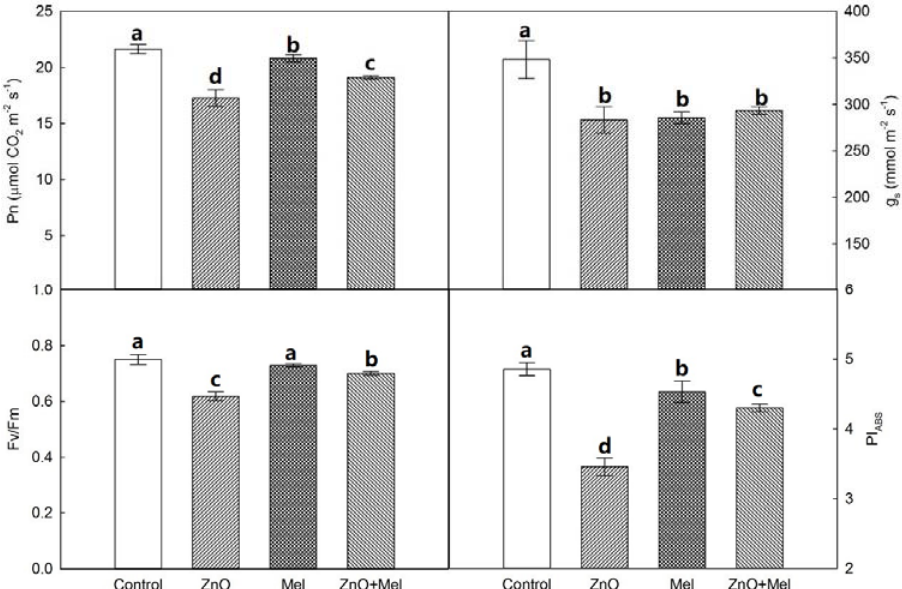
Figure 3. Net photosynthetic rate (Pn), stomatal conductance ( g s ), maximum quantum efficiency of photosystem II (Fv/Fm), and performance index (PI ABS ) in the last fully expanded leaf in wheat as affected by melatonin application and Zinc Oxide (ZnO) nanoparticles. Mel, melatonin. Data represent the mean ± SE of three replicates. Different letters indicate significant differences ( p < 0.05).